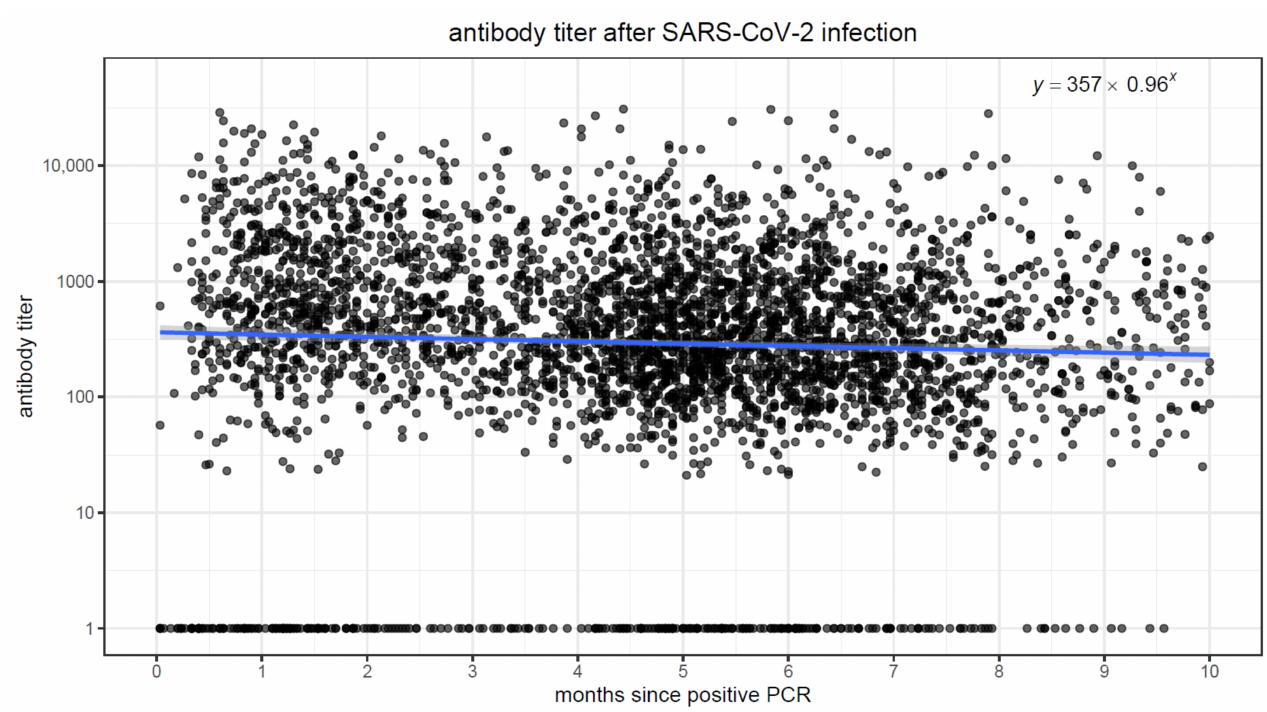
Figure 3. Scatter plot of time since second vaccination on the x-axis and antibody titer on the y-axis.